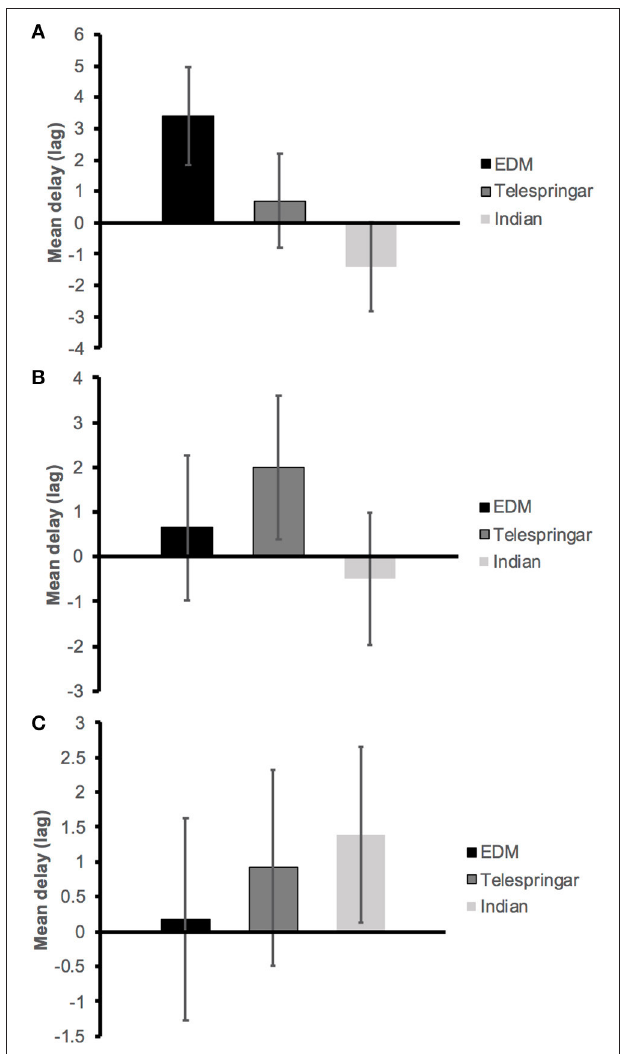
FIGURE 4 | Average lag of maximum cross-correlation (delay) between three-dimensional QoM and extracted sound features across participants for each music stimuli. (A) Loudness (RMS), (B) Spectral centroid, (C) Pulse Clarity.